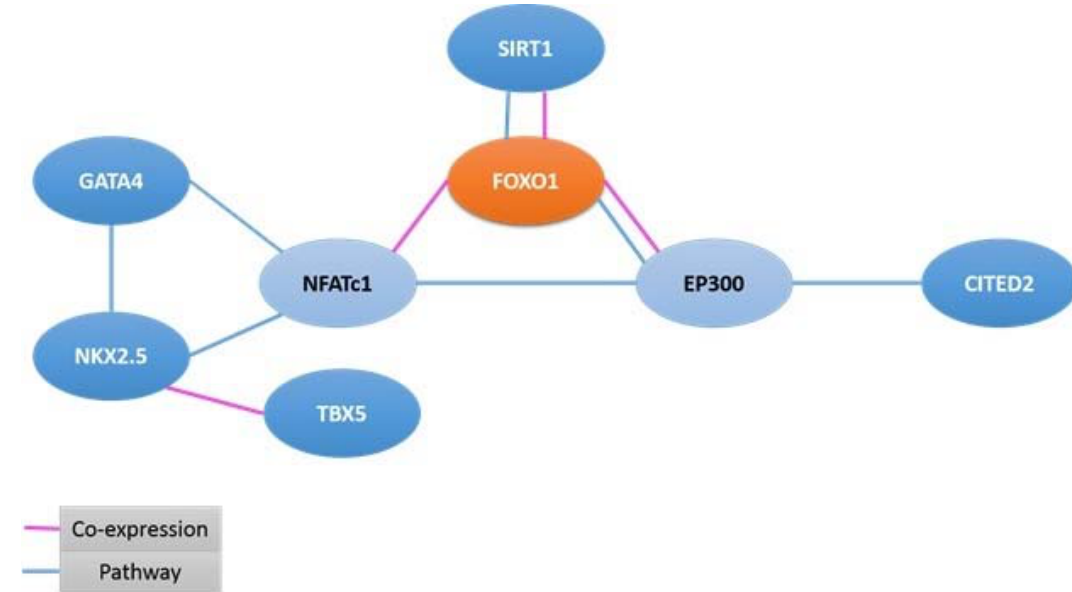
Figure 3. Protein–protein Interaction Partners (GATA4, NKX2-5, SIRT1, CITED, NFATc1, TBX5) of FOXO1. Table 3. Key genes strongly associated with the survival of PS patient.